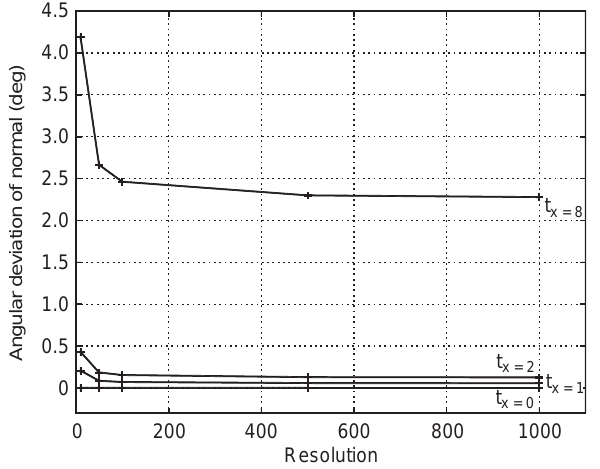
Fig. 6. Sensitivity of MVA analysis to the model shown in Figure 5 in terms of interval asymmetry.